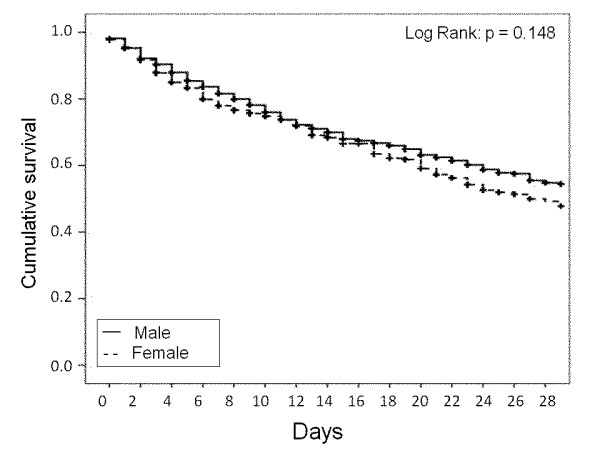
Kaplan-Meier survival curves representing 28-day survival according to
gender in the whole cohort.